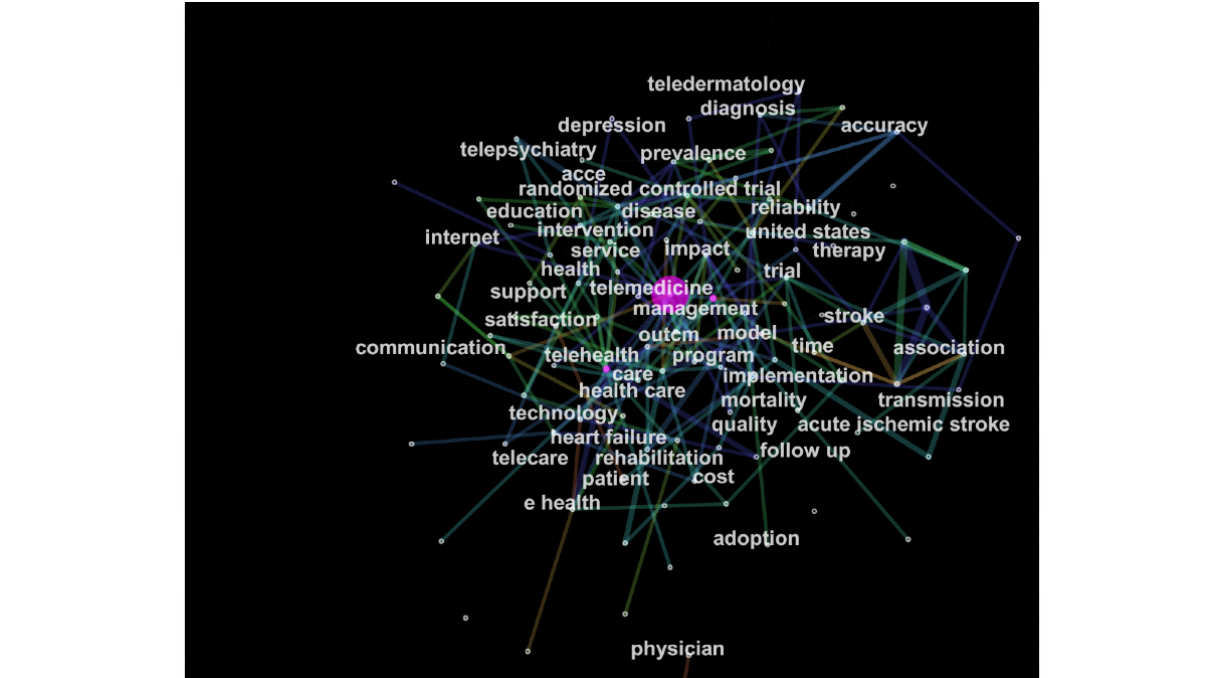
Figure 5. Research keywords in telemedicine research. acce: access; outcm: